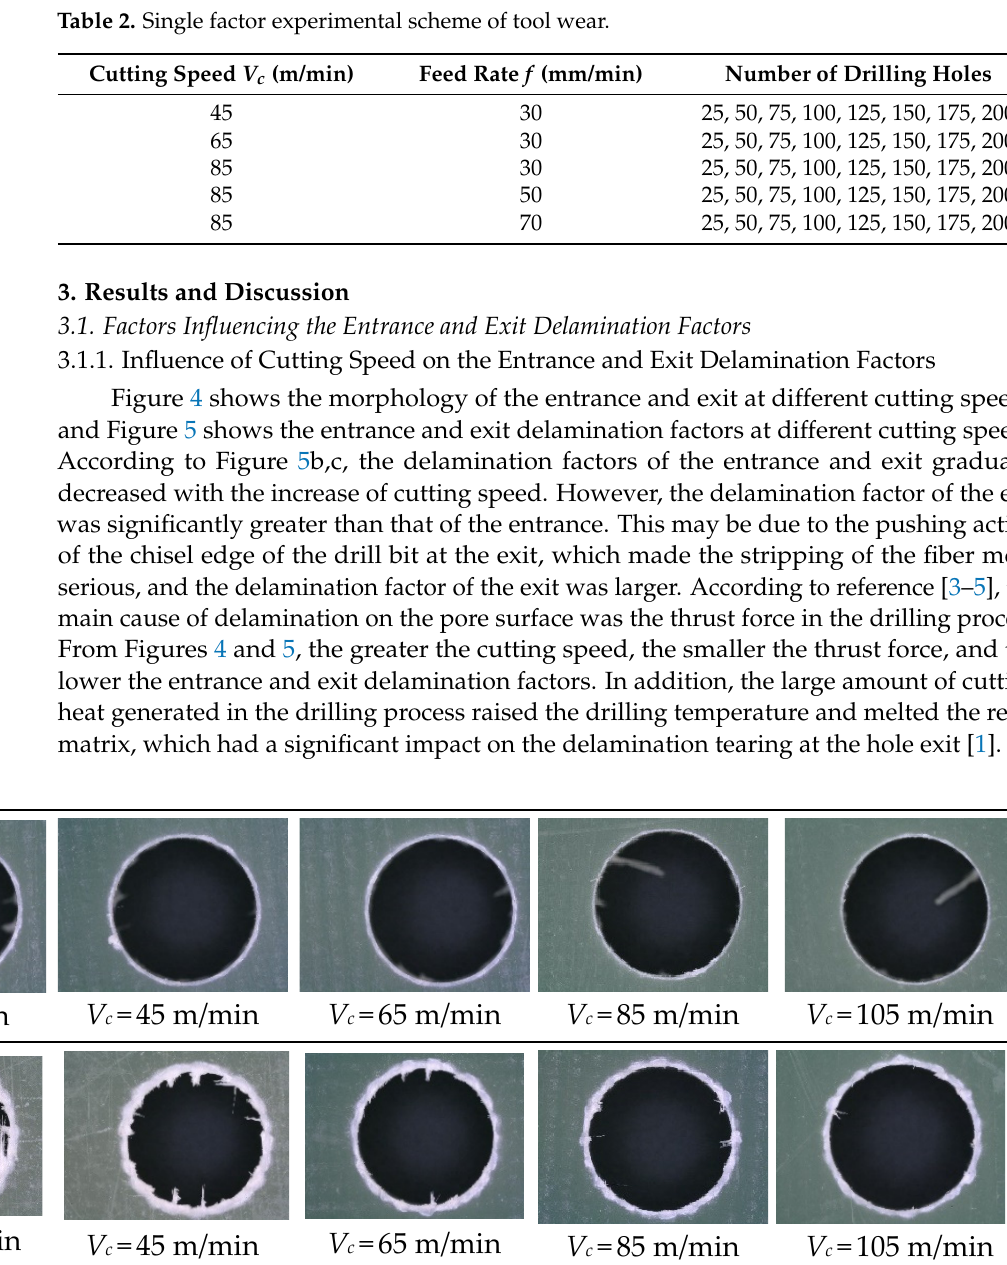
( c ) Figure 5. Entrance and exit delamination factors at different cutting speeds. ( a ) Effect of cutting speed on thrust force at different feed rates; ( b ) Entrance delamination factors at different cutting speeds; ( c ) Exit delamination factors at different cutting speeds. 3.1.2. Influence of Feed Rate on the Entrance and Exit Delamination Factors Figure 6 shows the morphology of the entrance and exit at different feed rates, and Figure 6 shows the entrance and exit delamination factors at different feed rates. With the increasing feed rate, the thrust force increased gradually, and the delamination factor of the entrance and exit also increased, as shown in Figure 7. At the entrance, with the